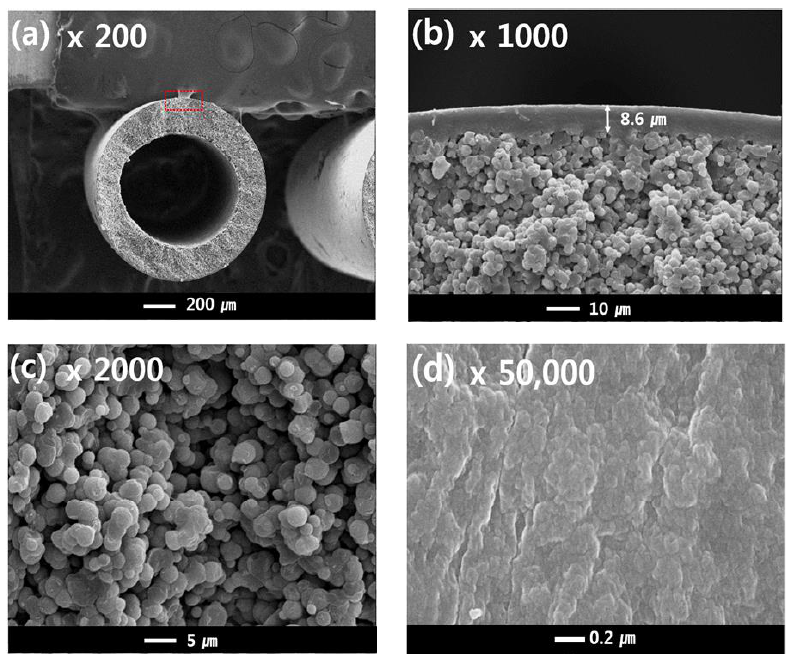
Figure 7. The morphology of the PVDF single layer hollow fiber membrane: cross-sectional images are at ( a ) 200×, ( b ) 1000×, and ( c ) 2000× magnification; ( d ) surface image at 50,000× magnification; Hollow fiber spinning conditions: Sample #1, TIPS = 17 g/min, NIPS = 0 g/min, Bore = 6 g/min.